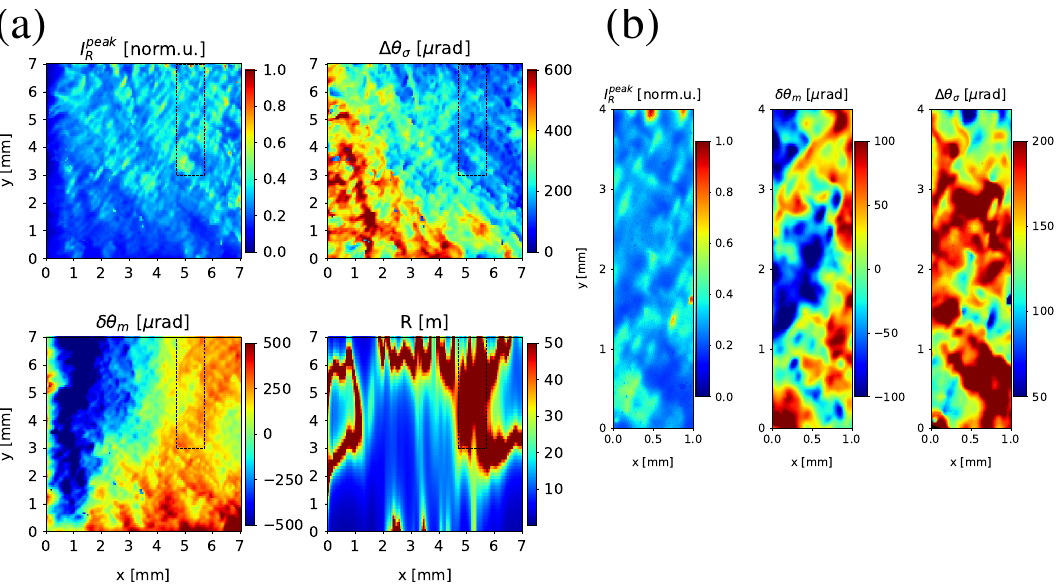
Figure 4. Rocking curve topographs for the (110)-edge oriented diamond crystal plate (CVD-N): ( a ) for the entire crystal showing maps of peak reflectivity ( I peak , normalized by the maximum value), R rocking curve peak position ( δθ m ), width ( ∆ θ σ ), and the effective radius of curvature R calculated from spline-interpolated δθ m ; ( b ) for the region of interest where the radius of curvature is maximized R 0 (cid:38) 50 m (shown by the dashed rectangle in ( a )). The x and y coordinates in ( b ) are shown with respect to the lower left corner of the rectangle. The limits of the colormaps for δθ m and ∆ θ σ in ( b ) are redefined to highlight variations in the mapped